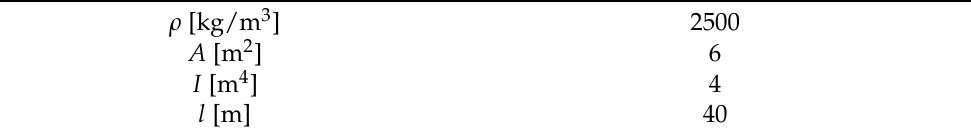
Table 1. Characteristics of the girders.